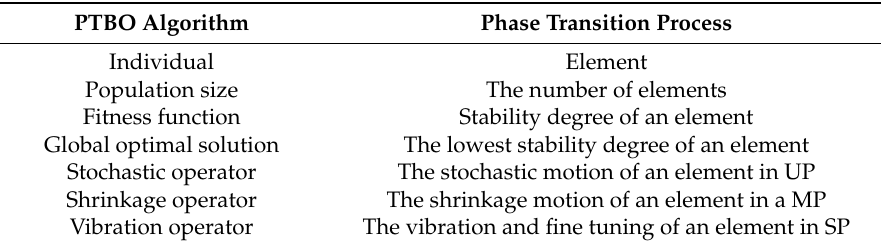
The correspondence of phase transition-based optimization (PTBO) algorithm and phase transition. PTBO Algorithm Individual Element Population size The number of elements Fitness